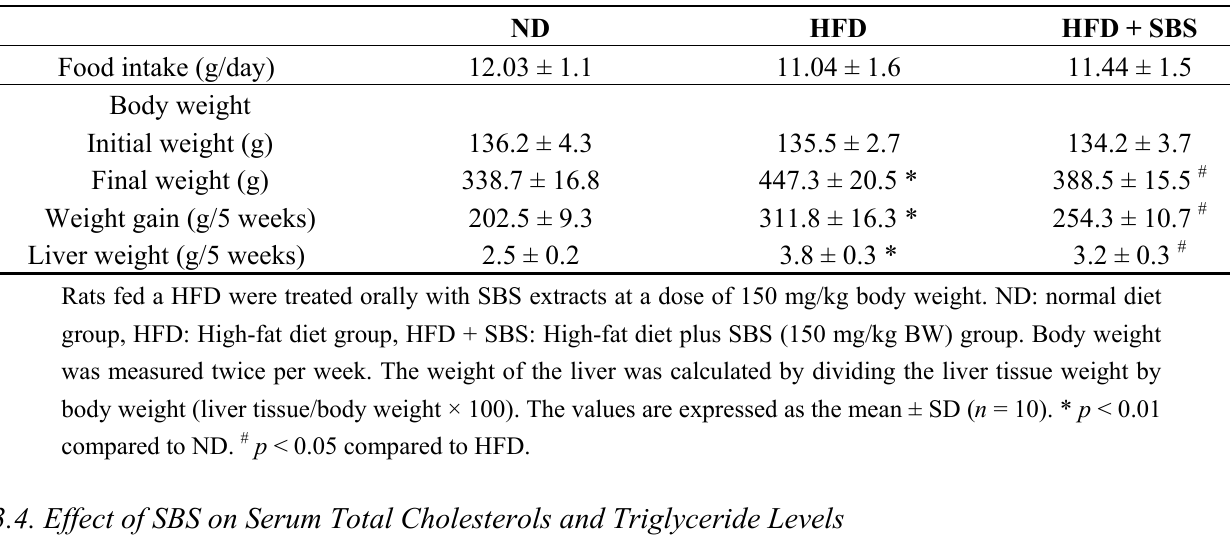
Table 4. Effects of SBS on body and liver weights in high-fat diet (HFD)-fed